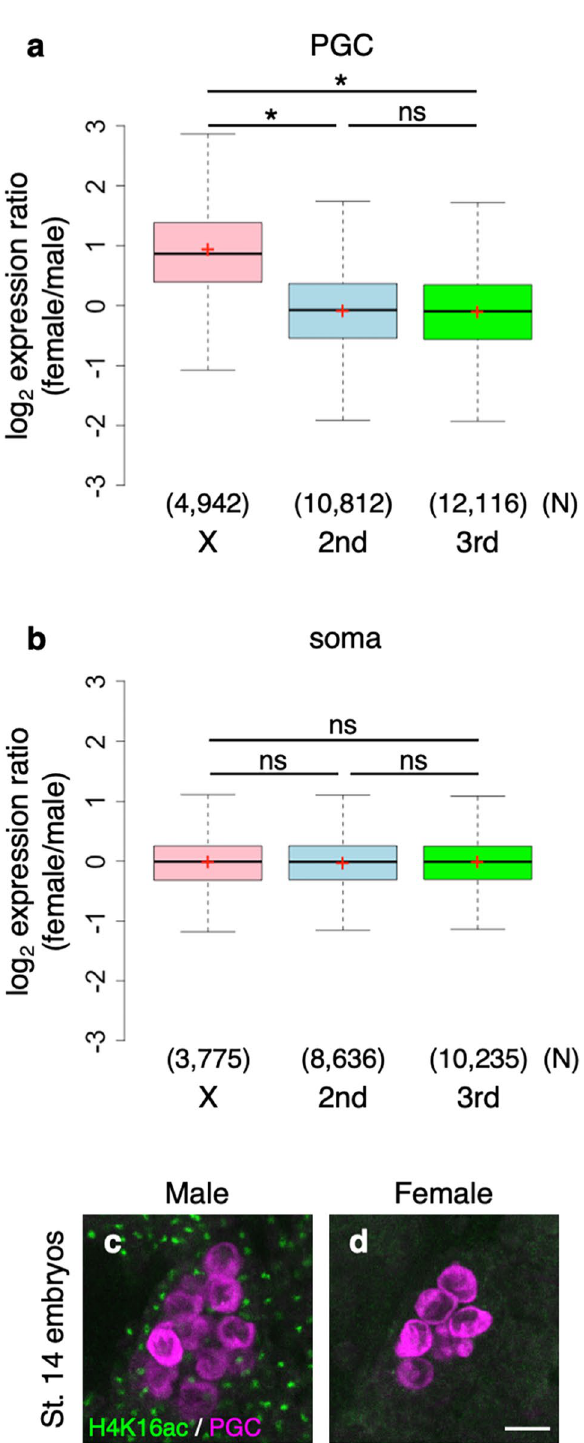
Figure 1. Dosage compensation is absent in embryonic PGCs. ( a ) Log 2 expression ratio of transcripts from genes on the X (pink), second (light blue), and third chromosomes (lime green) between female and male PGCs (female/male) at embryonic stages 12–16. Each box plot represents the median value and first and third quartile values. Error bars represent minimum and maximum values. Red plus signs represent mean values. Outliers are not depicted. The mean values for the transcripts from genes on the X, second, and third chromosomes were 0.94, − 0.08, and − 0.10, respectively. Significance was calculated by two-sided Mann–Whitney U test (*: P < 0.05, ns: not significant). Transcripts for which TPM were zero in all samples were excluded from this analysis. N: number of the transcripts examined. ( b ) Log 2 expression ratio of transcripts from genes on the X (pink), second (light blue), and third chromosomes (lime green) between female and male thoraxes (female/male) dissected from adults. This result was obtained from microarray data deposited by Meiklejohn et al. (GEO accession No. GSE30850) 11 . Each box plot represents values as in ( a ). The mean values for the transcripts from genes on the X, second, and third chromosomes were − 0.01, − 0.02, and − 0.01, respectively. Significance was calculated by two-sided Mann–Whitney U test (ns: not significant). N: number of the probes examined. ( c and d ) H4K16ac expression in male ( c ) and female ( d ) PGCs at embryonic stage 14 (St. 14). y w embryos were stained for H4K16ac (green) and Vasa [a marker of germline cells (magenta)]. Embryos were sexed based on H4K16ac staining in the soma. Scale bar: 10